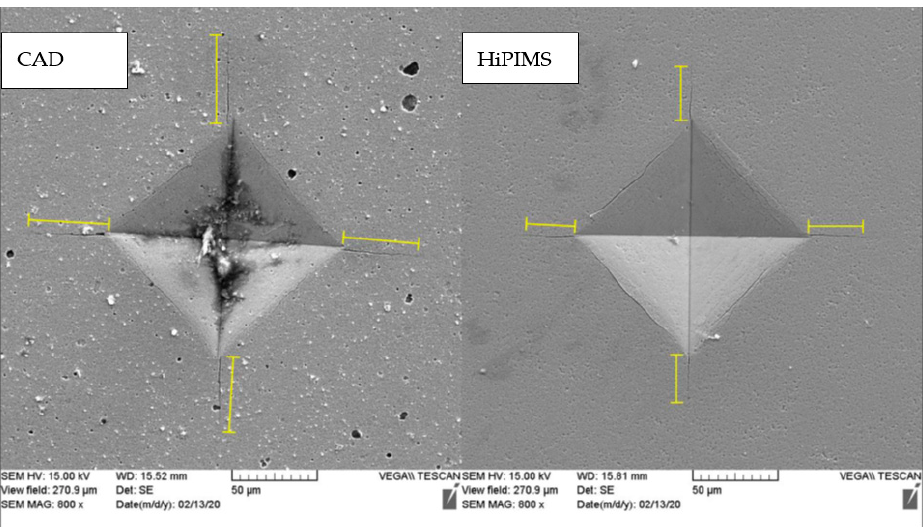
Figure 7. Fracture toughness of the studied coatings.